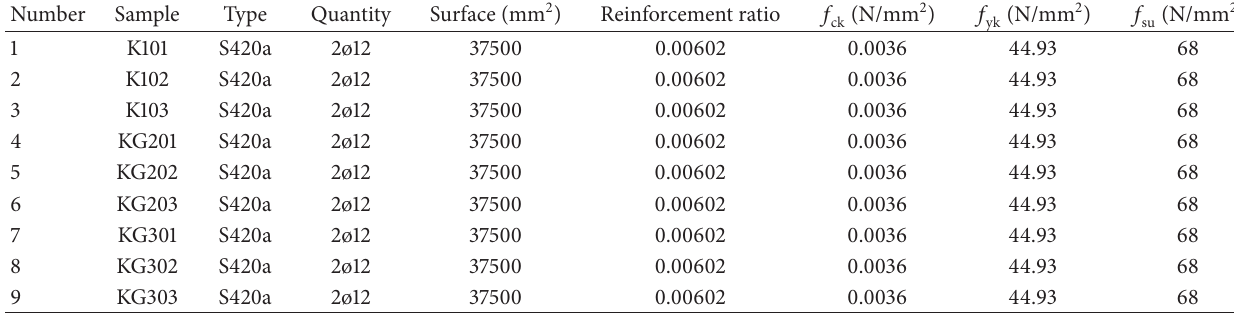
Table 3: Mechanical properties of the sample beams.